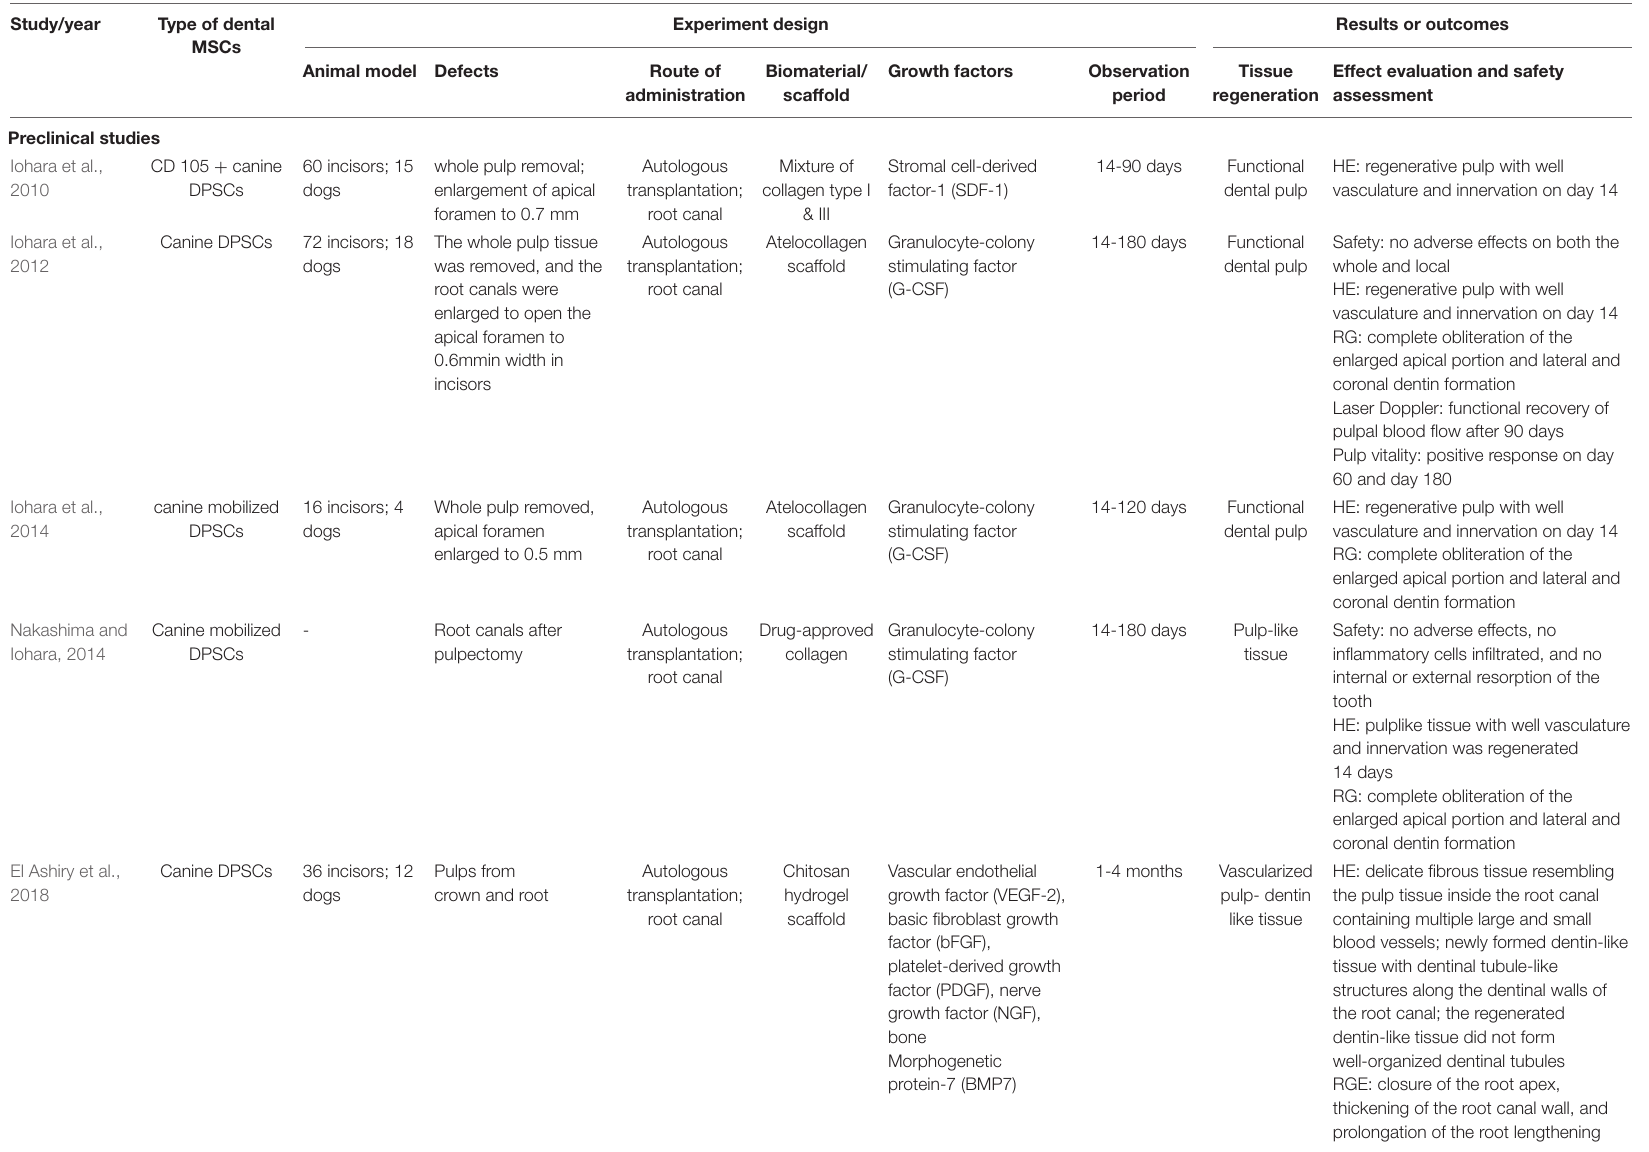
TABLE 3 | Current preclinical and clinical studies of REPs based on dental MSCs.